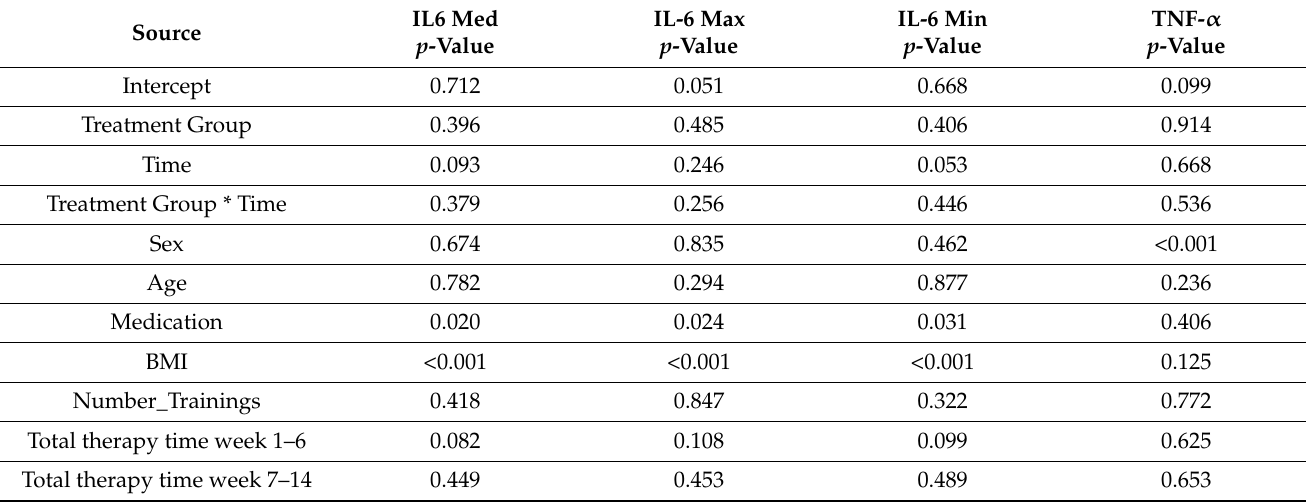
Table 4. Influences of covariates on IL-6 and TNF- α fixed effects of mixed model analysis. Source